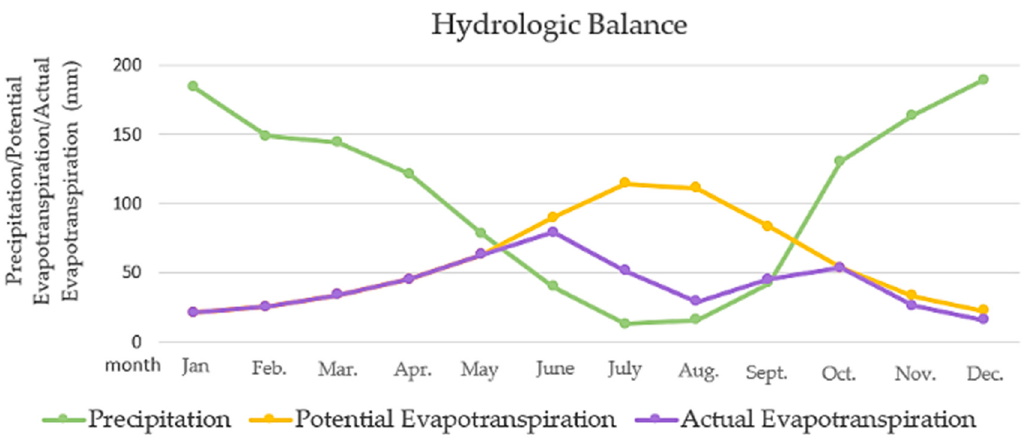
Figure 6. Monthly hydrological balance for the studied area.